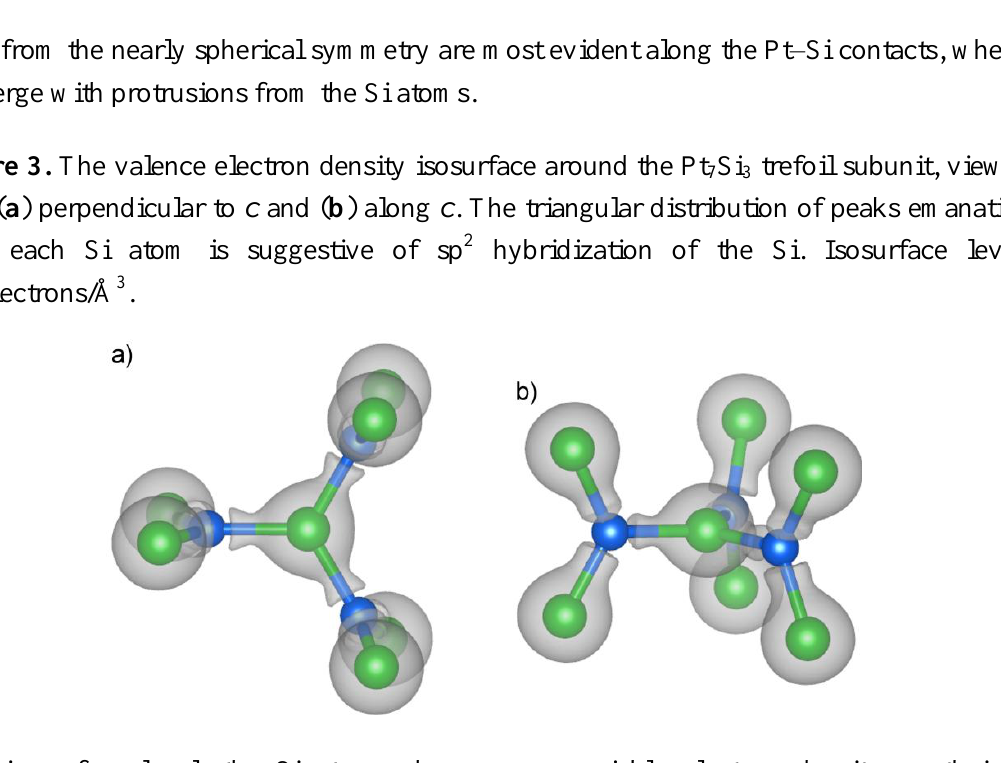
Si trefoil subunit, viewed 7 3